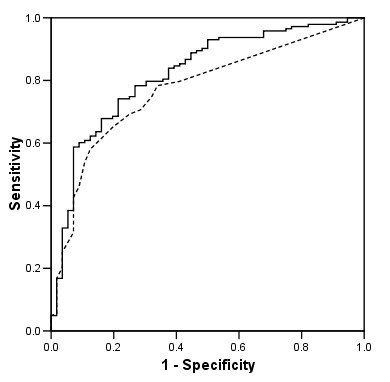
Prediction of the follow-up haemoglobin. ROC curves plotting sensitivity against 1 minus specificity for a cut-off of 11.0 g/dL in the prediction of the haemoglobin one month later obtained from the nephrologists (dotted line) and from the best performing ANN (continuous line) (using as input variables the haemoglobin and epoetin dose from the currently and the 2 previous months). The areas under the curves, the 95% confidence intervals and the significance P for the Nephrologists and the ANN were respectively: 0.772 (0.702–0.881), P < 0.001 and 0.822 (0.758–0.887), P < 0.001(the difference between the two curves was not significant).